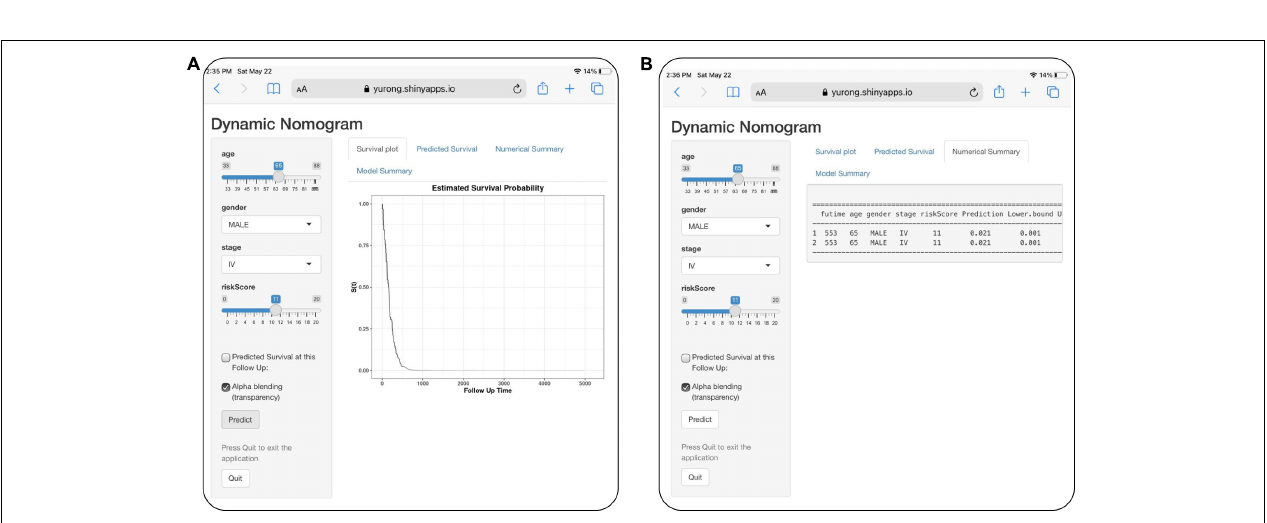
FIGURE 10 | Development of an easy-to-operate web-based calculator for predicting overall survival in patients with LUAD (https://jiangyanxia.shinyapps.io/LUAD/). (A) Web-based overall survival rate calculator. (B) The 95% confidence interval of the web-based progression-free survival rate.